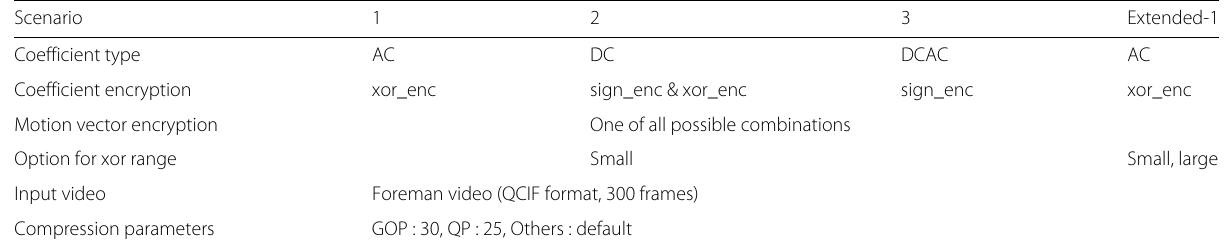
Table 3 Experimental scenarios of the JVCE under consistent set of parameters of video compression while varying several parameters of video encryption (Foreman